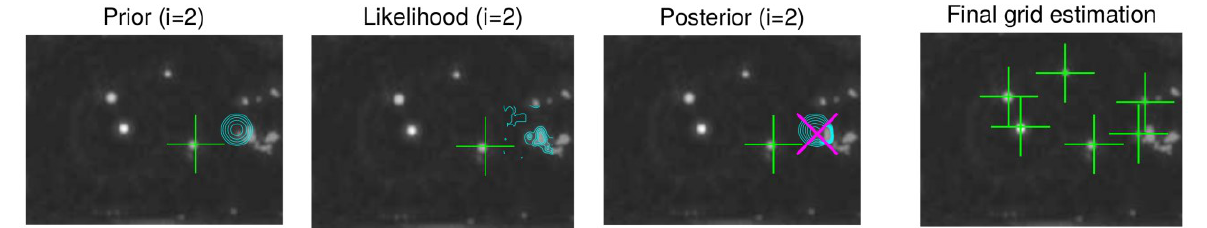
Figure 10 An illustrative example of finding glint when there are additional false reflections around the correct glint. The likelihood of the second glint is multimodal. The prior assumption about the glint location causes the MAP to be in the correct location. The rightmost image shows the estimated grid